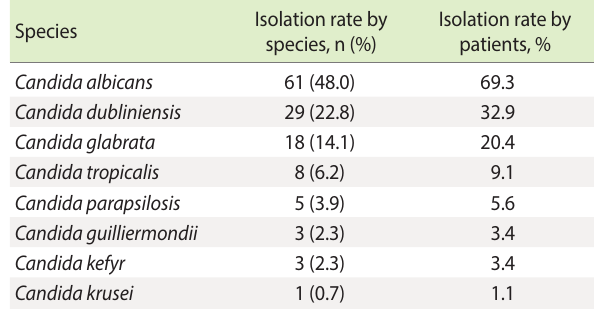
Table 4. Prevalence rates of oral colonization by Candida species Variables